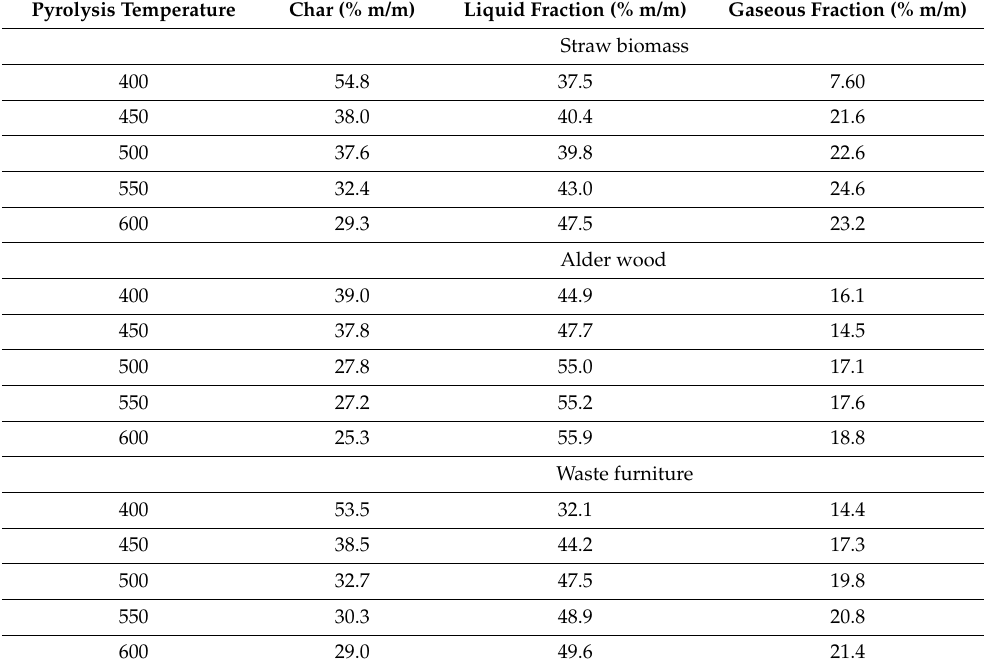
Table 4. Mass balance of products (average) from pyrolysis biomass